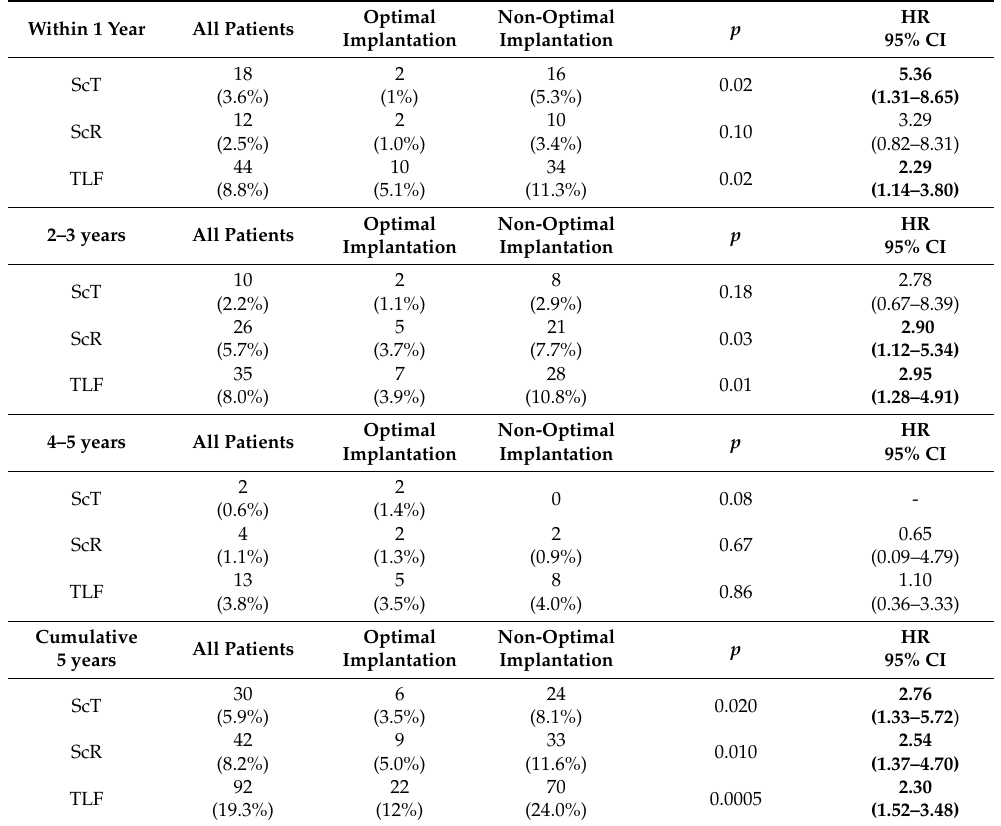
Table 1. Number of events and annualized Kaplan-Meier (KM) risk of adverse events divided by patients with and without optimal implantation and respective hazard ratios (HR) in univariate Cox regression analysis during whole observation period of 5 years. TLF: target lesion failure; ScR: sca ff old restenosis; ScT; sca ff old thrombosis. Bold character identifies parameters associated with p values <